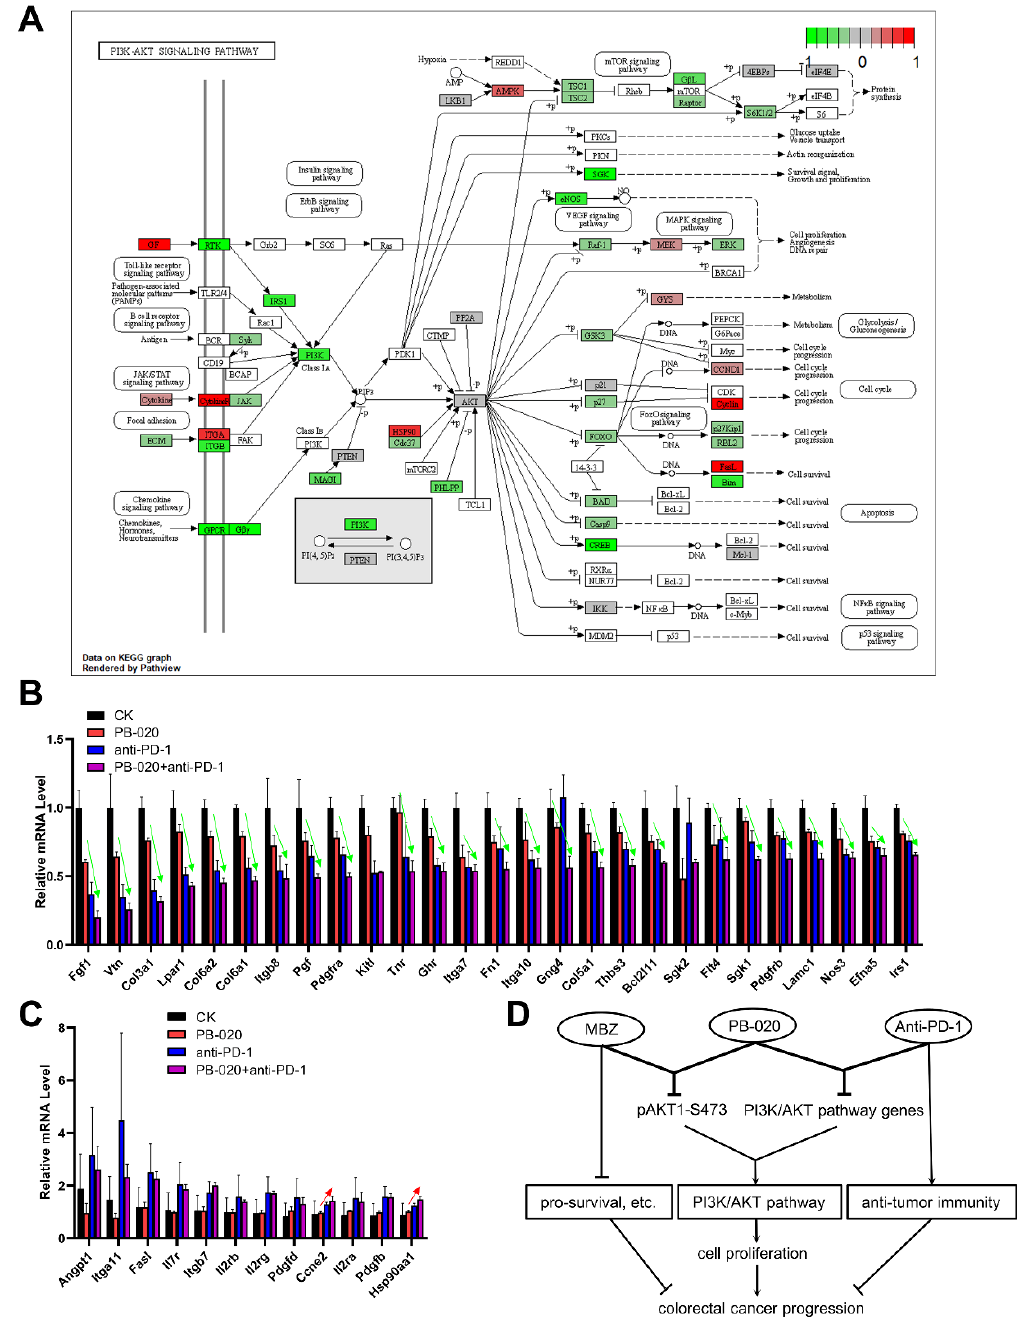
Figure 6. PB-020 in combination with PD-1 blockade suppressed the transcription of PI3K/AKT pathway genes. ( A ) The identified DE genes in the PB-020/anti-PD-1 combination group versus control group were largely involved in the PI3K/AKT signaling pathway. ( B ) Fold change in down- regulated PI3K/AKT pathway genes in the PB-020 group, anti-PD-1 group and PB-020/anti-PD-1 combination group versus the control, respectively. Green arrows indicate synergistic or additive suppression effects. ( C ) Fold change in up-regulated PI3K/AKT pathway genes in the PB-020 group, anti-PD-1 group and PB-020/anti-PD-1 combination group versus the control, respectively. Red arrows indicate synergistic or additive enhancement effects. ( D ) Graphical summary of the key findings of this work.